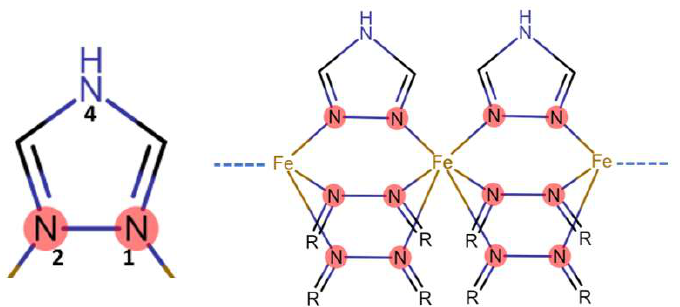
Figure 1. Left, triazole ligand with nitrogens at the 1, 2, and 4 positions. Right, triazole complex showing the N 1 , N 2 triazole triple bridge that supports the 1D coordination chains of the structure. (R is used to simplify image, and represents bridging nitrogen (4) as shown in the 1,2,4-triazole ligand on the left.)